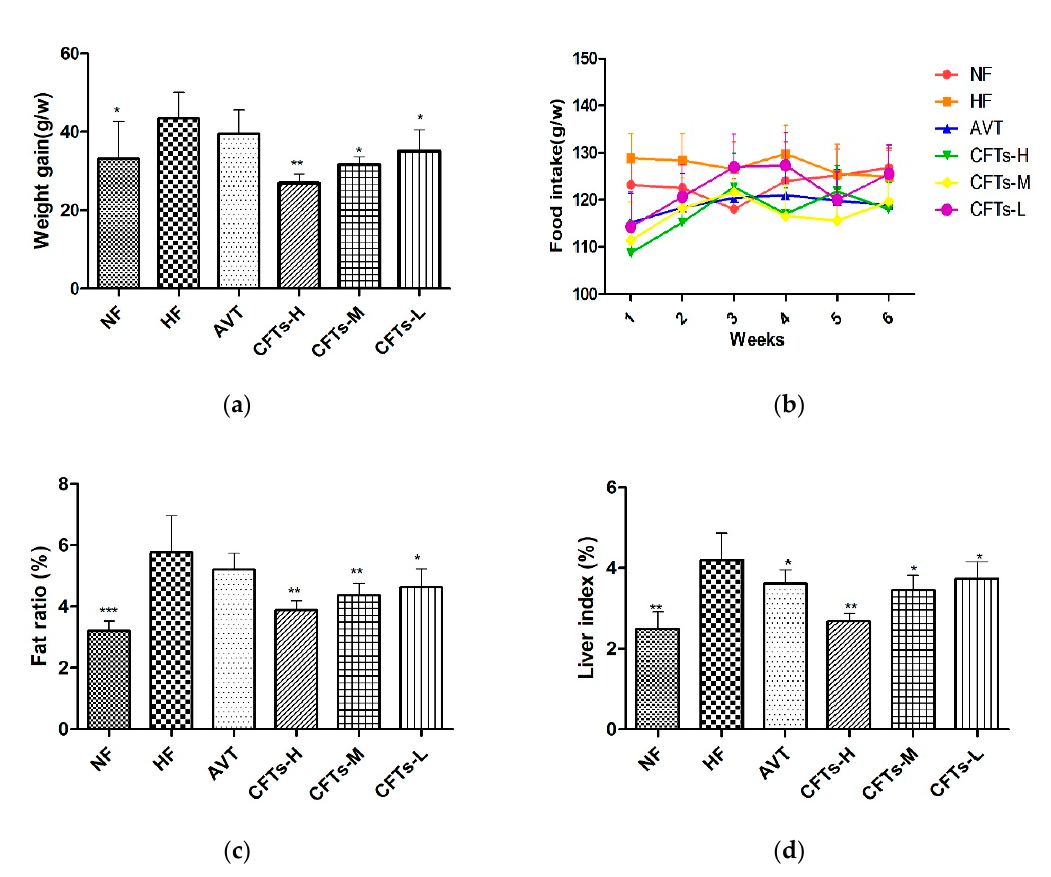
Figure 1. The main index of rats. ( a ) weight gain; ( b ) food intake; ( c ) fat ratio; ( d ) liver index. The data are presented as the means ± SD ( n = 10). Compared to HF group, * p < 0.05; ** p < 0.01; *** p < 0.001.